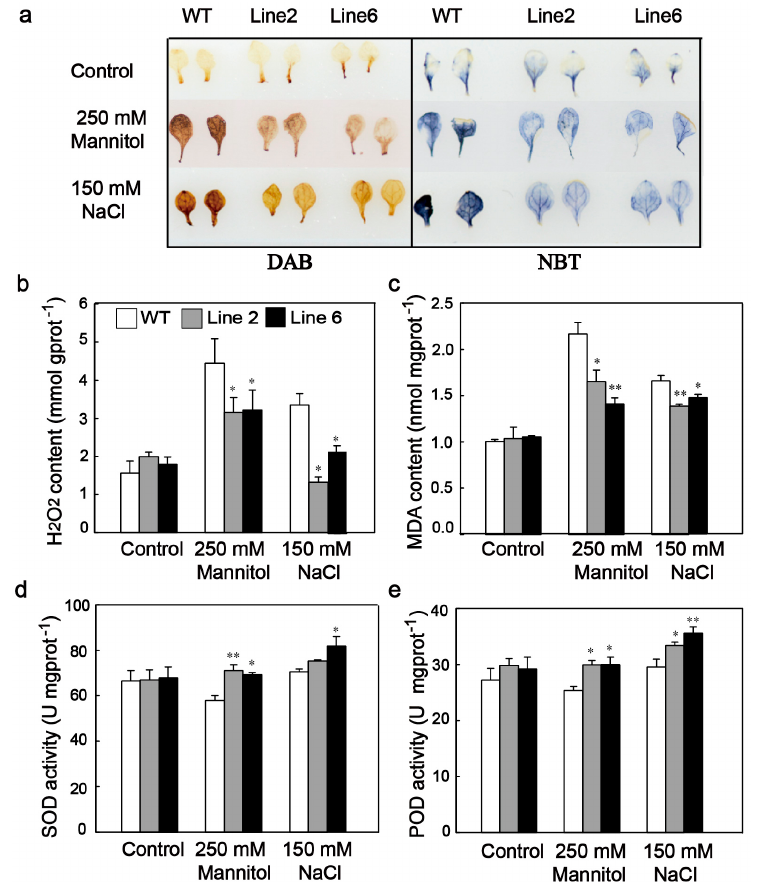
Figure 5. Comparison of reactive oxygen species (ROS) levels and antioxidant enzyme activities between WT and transgenic Arabidopsis under osmotic and salt stresses. One-week-old seedlings of WT and transgenic Arabidopsis cultured on MS medium were transferred on the MS agar plates (control), MS agar plates supplied with 250 mM mannitol (osmotic stress) or 150 mM NaCl (salt stress), and maintained for 7 days, then leaves were collected for histochemical staining and physiological indexes measurement. ( a ) Histochemical detection of hydrogen peroxide (diaminobenzidine (DAB) staining) and superoxide anion (nitrotetrazolium blue chloride (NBT) staining) accumulation. Measurement of H 2 O 2 and malondialdehyde (MDA) contents ( b , c ). Measurement of superoxide dismutase (SOD), peroxidase (POD) activities ( d , e ) from 7-day-old seedlings. Values are means ± SE of three replicates. Asterisks indicate statistically significant differences from WT (* P < 0.05, ** P <